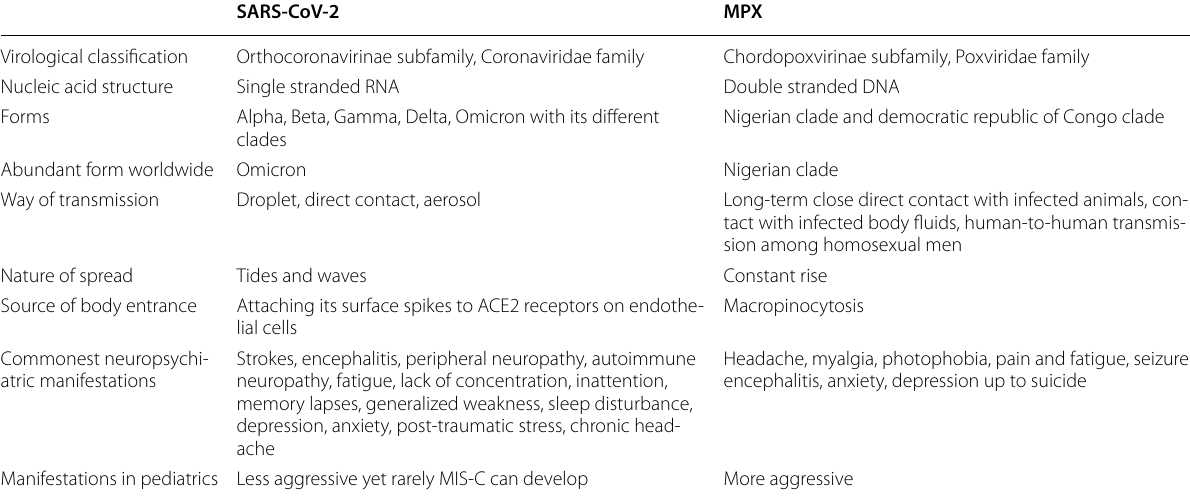
SARS-CoV-2: severe acute respiratory syndrome corona virus 2, MPX: monkeypox virus, RNA: ribonucleic acid, DNA: deoxyribonucleic acid, ACE2: angiotensin converting enzyme 2 receptors, MIS-C: multisystem inflammatory syndrome in